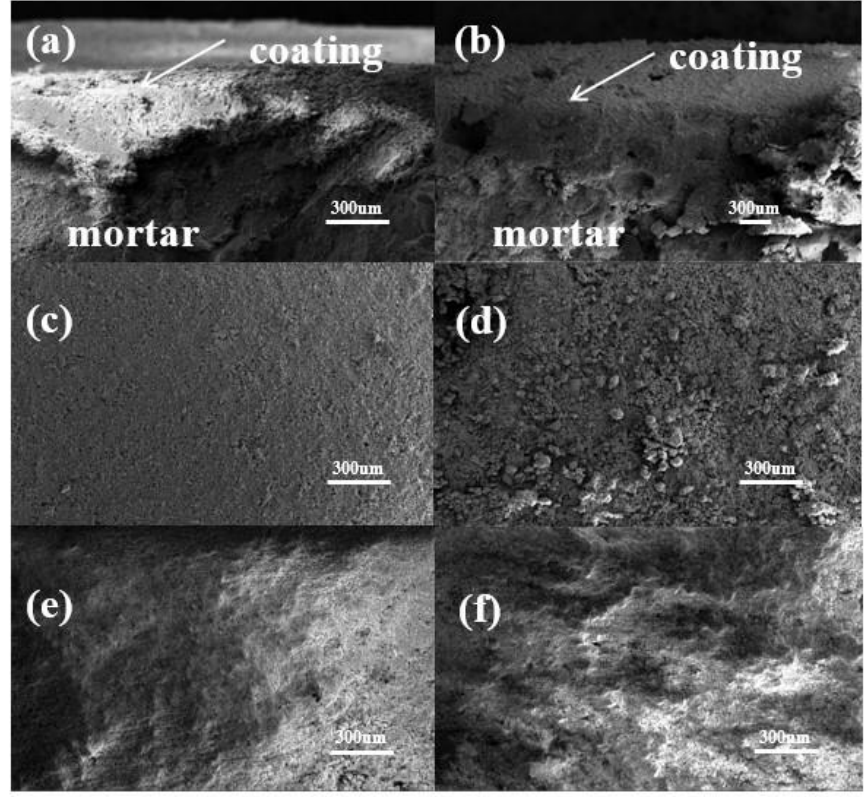
Figure 12. Morphologies of the cross sections and surfaces of the coated mortars before and after wearing: ( a , c , e ) for MC; ( b , d , f ) for ML.